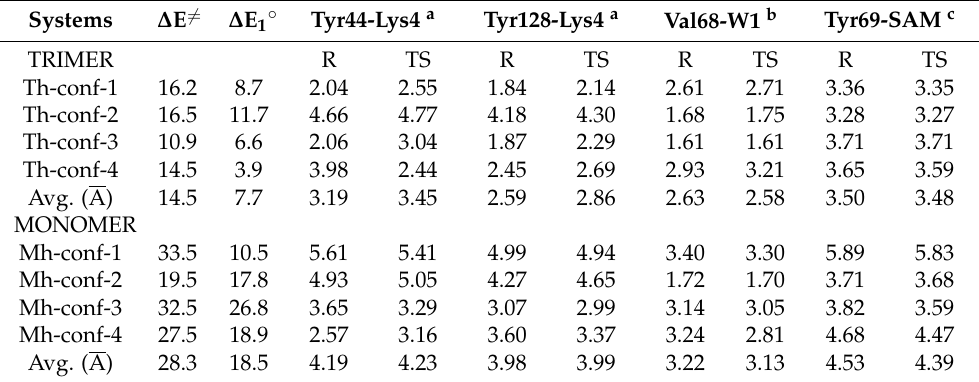
Table 1. Barrier heights ( ∆ E (cid:54) = ), reaction energies ( ∆ E 1 ◦ ) and selected geometric parameters found at the reactants and Transition Structure (TS) that reveal the main differences for the deprotonation process between M3RA and MLL3 (Distances are in Å and energies in kcal/mol). T(M)h-conf-N indicates the trimer (or monomer) configuration, where N denotes the sampling window from which it was